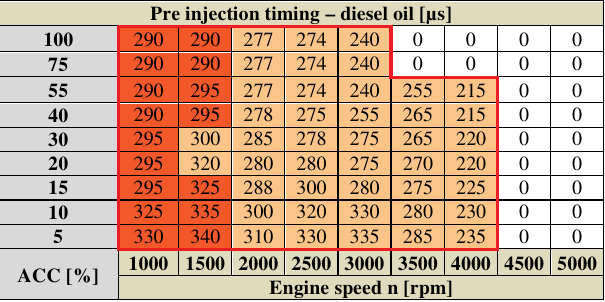
Table 3. Control algorithm of opening time of Diesel oil injectors for Pre dose at dual fuel supply of the engine